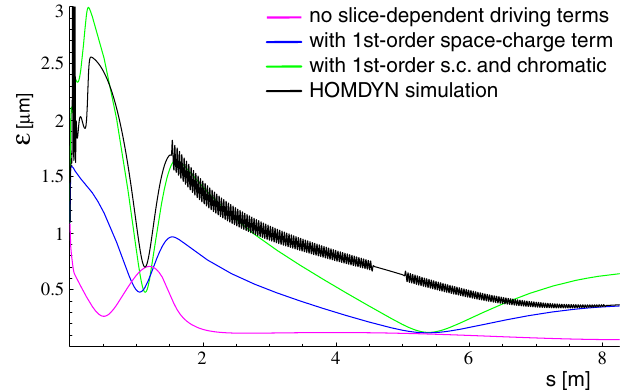
FIG. 5. (Color) Effects of first-order driving terms on the emit- tance via Eq. (12). The black and magenta curves are the same as in Fig. 4. The blue curve includes only space-charge and the green curve includes both space-charge and chromatic driving terms in Eq. (8).